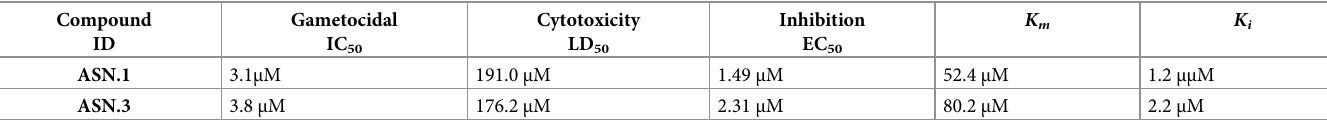
Table 3. The activity of inhibitors towards gametocytes, cell cytotoxicity and inhibition kinetics ( Km and Ki ) of Pf PMT protein. Compound ID